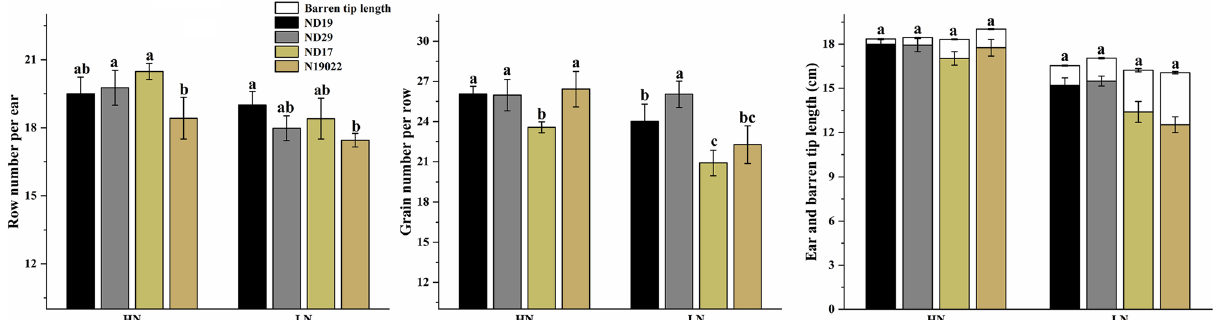
Figure 1. Row number per ear, grain number per row, ear and barren tip length of the four varieties under different nitrogen rate. Result is the average from 2018 to 2019. Error bars are given as S.E. HN high nitrogen conditions, LN low nitrogen conditions. The different small letters above the column indicate significant difference among cultivars in the same N condition during the same growth stage at P <